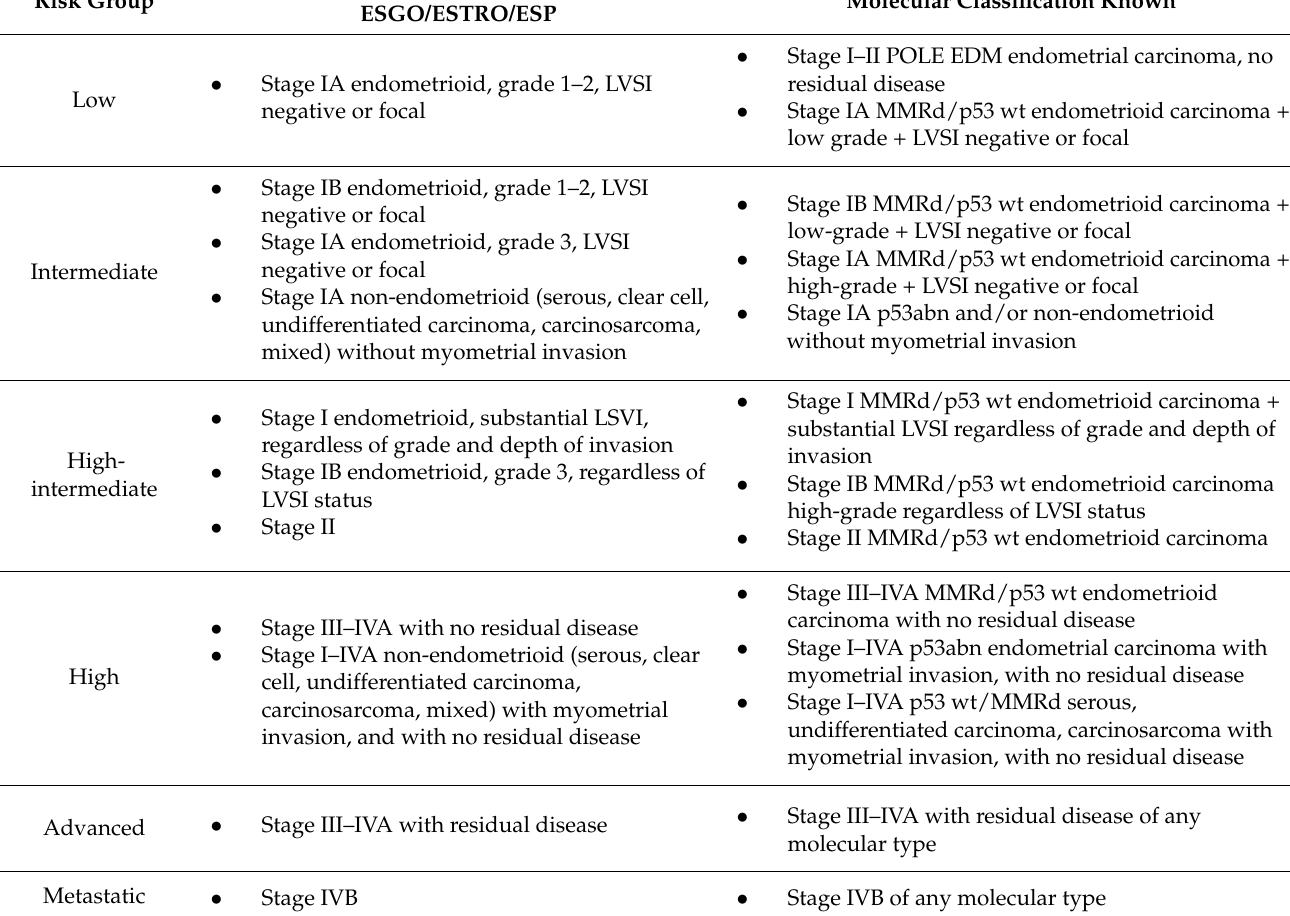
Table 1. ESGO/ESTRO/ESP 2020 recommendations on risk stratification after “ProMisE” genomic classification (right) compared to clinical risk stratification